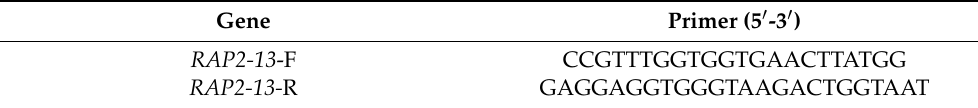
Table 6. The primer sequences of RAP2-13